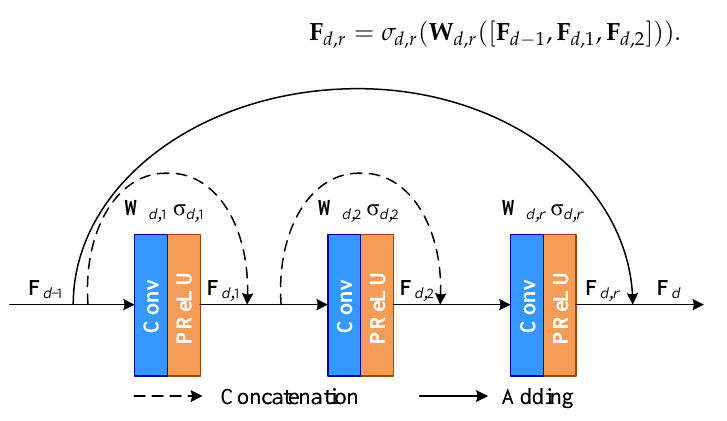
Figure 5. Architecture of the